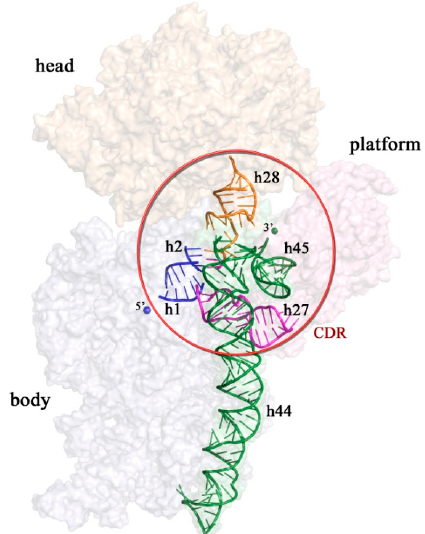
Figure 1. Main steps of the small ribosomal subunit (30S) assembly in bacteria. The steps are de ‐ scribed in the main text in more detail. Hierarchical incorporation of the ribosomal proteins corre ‐ sponds to Nomura assembly map [6]. Unprocessed 5 ′‐ and 3 ′‐ ends of the 17S rRNA are shown in red and green, respectively.